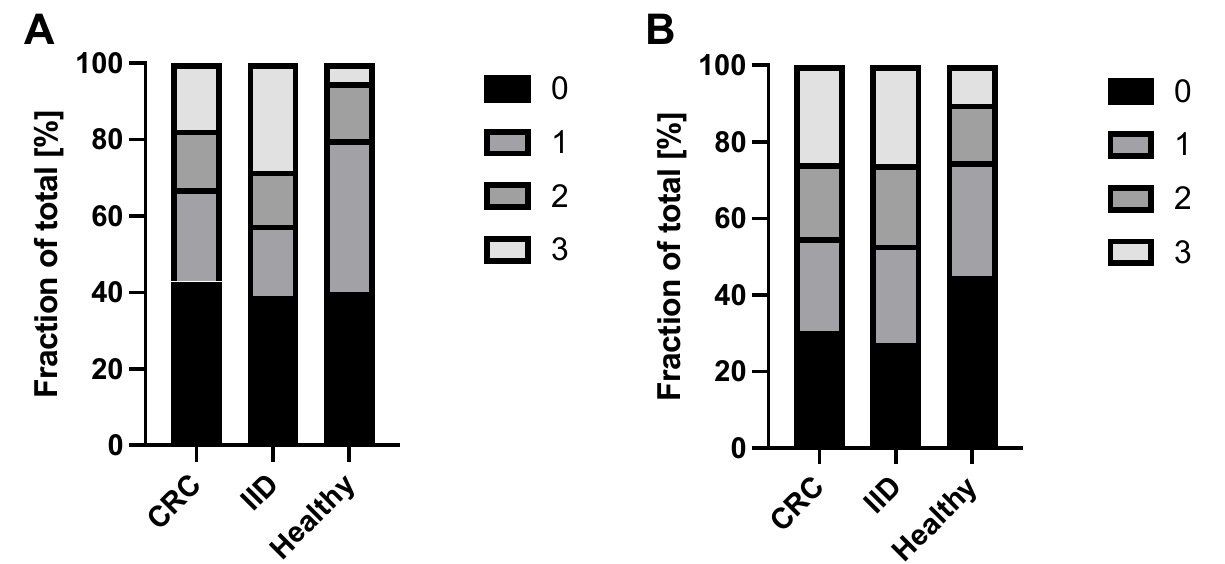
Figure 1. Detection rate of CK20 and DEFA5 in blood samples of CRC and IID patients as well as healthy controls. MNC-derived cDNA from n = 98 CRC patients, n = 64 IID patients and n = 40 healthy controls was analyzed by RT-qPCR for expression of ( A ) CK20 and ( B ) DEFA5. Data are presented as % of samples with no (0), one (1), two (2), or all (3) positive triplicates in the RT-qPCR.